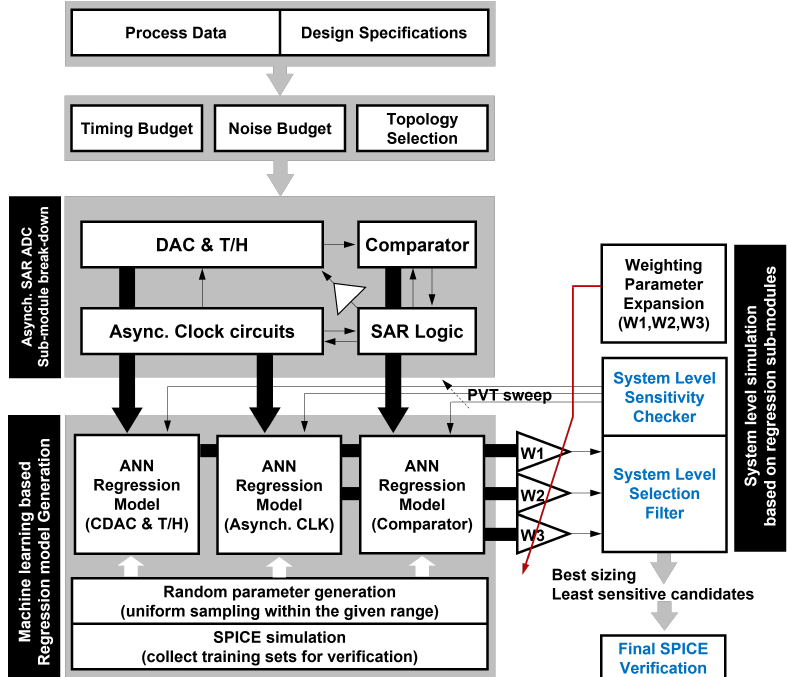
Figure 9. Regression model (ANN)-based asynchronous SAR ADC design